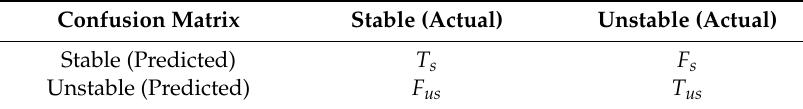
Table 2. Confusion matrix of transient stability assessment